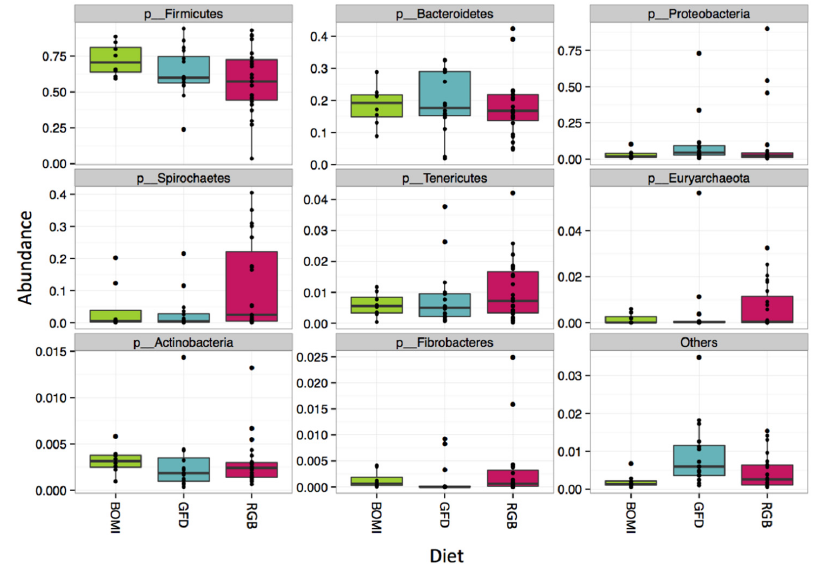
Figure 5. Composition at the phylum level. Irrespective of diet, the phylum Firmicutes comprised the majority of the gut microbiome in GS macaques.